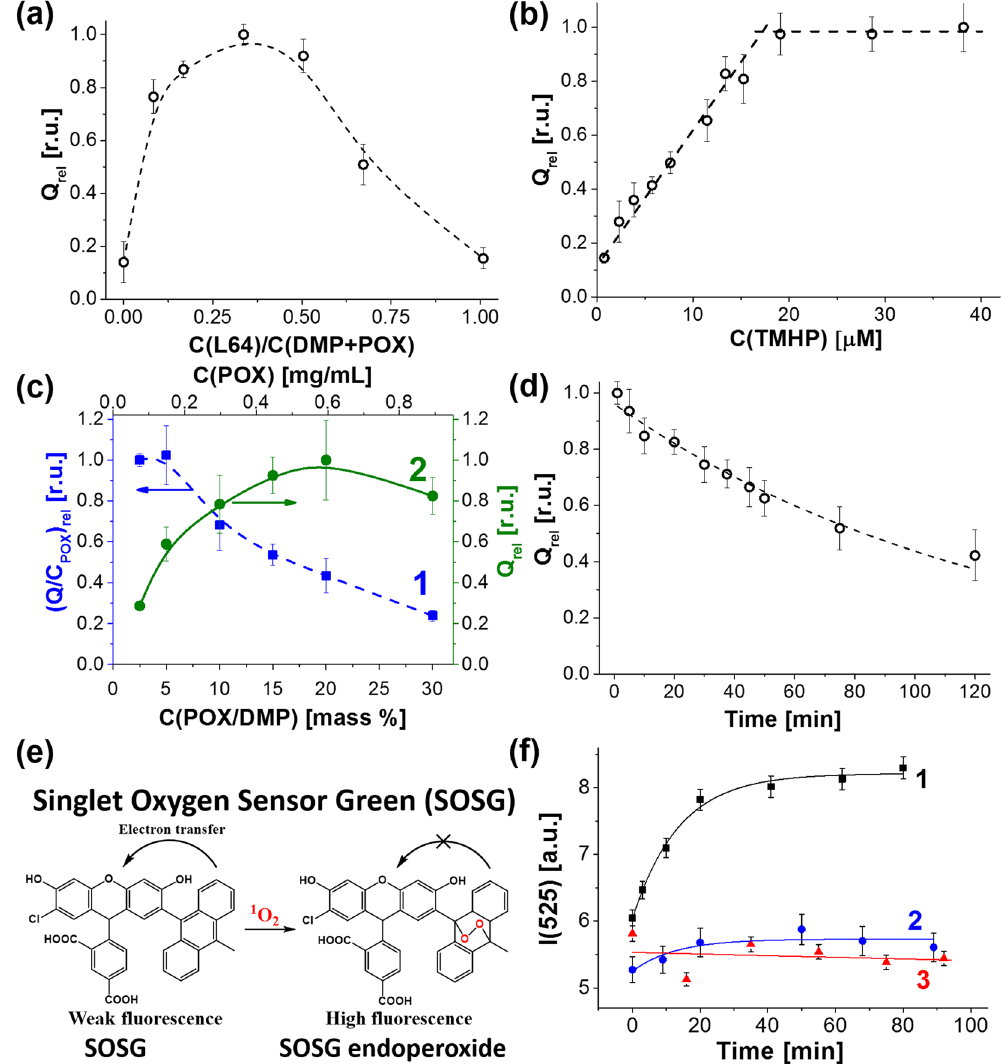
Figure 4. Relative integral intensity of PO-CL reaction (Q rel = Q/Q max ) as a function of the composition of the dispersions and evidence for singlet oxygen generation in PO-CL reaction in cell-free system. ( a ) Variation of Pluronic L64 content expressed as its weight ratio toward the organic phase (DMP + POX). C(DMP) = 2.7 mg/ mL, C(POX) = 0.3 mg/mL, C(TMHP) = 7.6 μ M; ( b ) Variation in TMHP concentration. C(L64) = 1.0 mg/ mL, C(DMP) = 2.7 mg/mL, C(POX) = 0.3 mg/mL. ( c ) Variation in POX content: (1) normalized PO-CL efficiency per POX amount (left axis, (Q/C POX ) rel = (Q/C POX )/(Q/C POX ) max ) and (2) the relative integral intensity (right axis) on the overall POX concentration (top axis) and POX fraction in DMP solution (bottom axis). C(L64) = 1.0 mg/mL, C(DMP + POX) = 3.0 mg/mL, C(TMHP) = 7.6 μ M; ( d ) The kinetics of hydrolysis of POX in the dispersions of L64/DMP/POX (1:2.7:0.3 weight ratio). In all experiments C(imidazole) = 26 mM, C(H 2 O 2 ) = 15.0 mM. ( e ) Structure of Singlet Oxygen Sensor Green fluorescent probe and the reaction of its oxidation by singlet oxygen. ( f ) Kinetics of SOSG oxidation in the presence of 30 µ M H 2 O 2 and complete CLD (1), the dispersion without TMHP (2), or POX